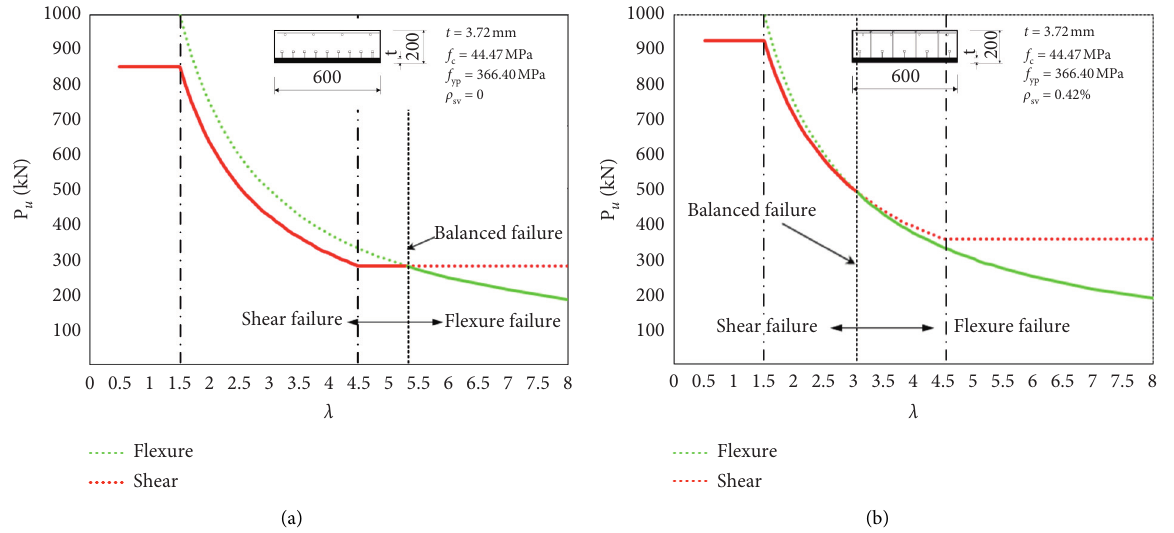
Figure 23: Ultimate load versus shear span ratio curves: (a) ρ